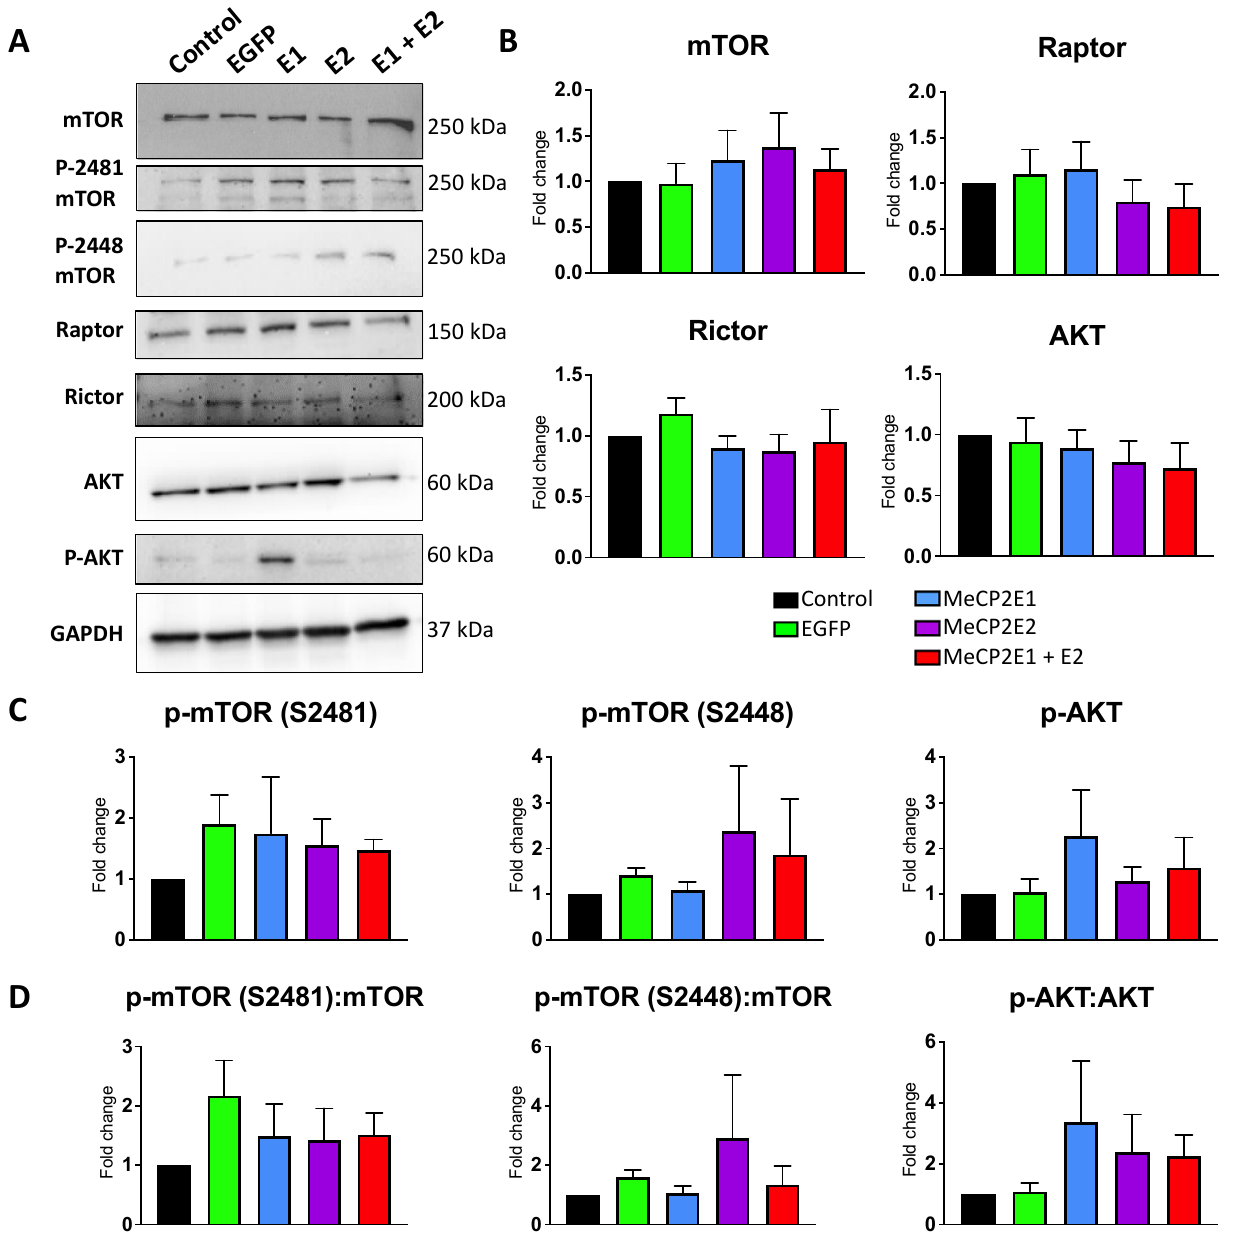
Figure 9. Protein analysis of components of the mTOR and AKT pathways in Daoy cells transduced with lentiviral vectors overexpressing MeCP2 isoforms. ( A ) Western blot analysis of the indicated proteins in non-transduced control Daoy cells, EGFP-transduced (EGFP), E1-transduced (E1), E2- transduced (E2), and E1 + E2-tranduced (E1 + E2) cells. ( B ) Quantification of the indicated pan total proteins from A. ( C ) Quantification of the indicated phosphorylated proteins from A. ( D ) Ratio analysis of the phosphorylated proteins from A versus their own non-phosphorylated pan total proteins. n = 4–6 ( n = 4 for mTOR, p-mTOR (S2481), p-mTOR (S2448), and Rictor; n = 5 for p-AKT, n = 6 for AKT and Raptor), and data are reported as mean ± SEM. For ratio of phosphorylated proteins to their pan protein abundances (Part D ), samples from the same biological replicate were analyzed against the pan proteins from the same set. For the reported ratios, where n is different for the phosphorylated proteins versus their pan protein, n for the ratio would be equal to the lowest n within the phospho-pan protein pair.